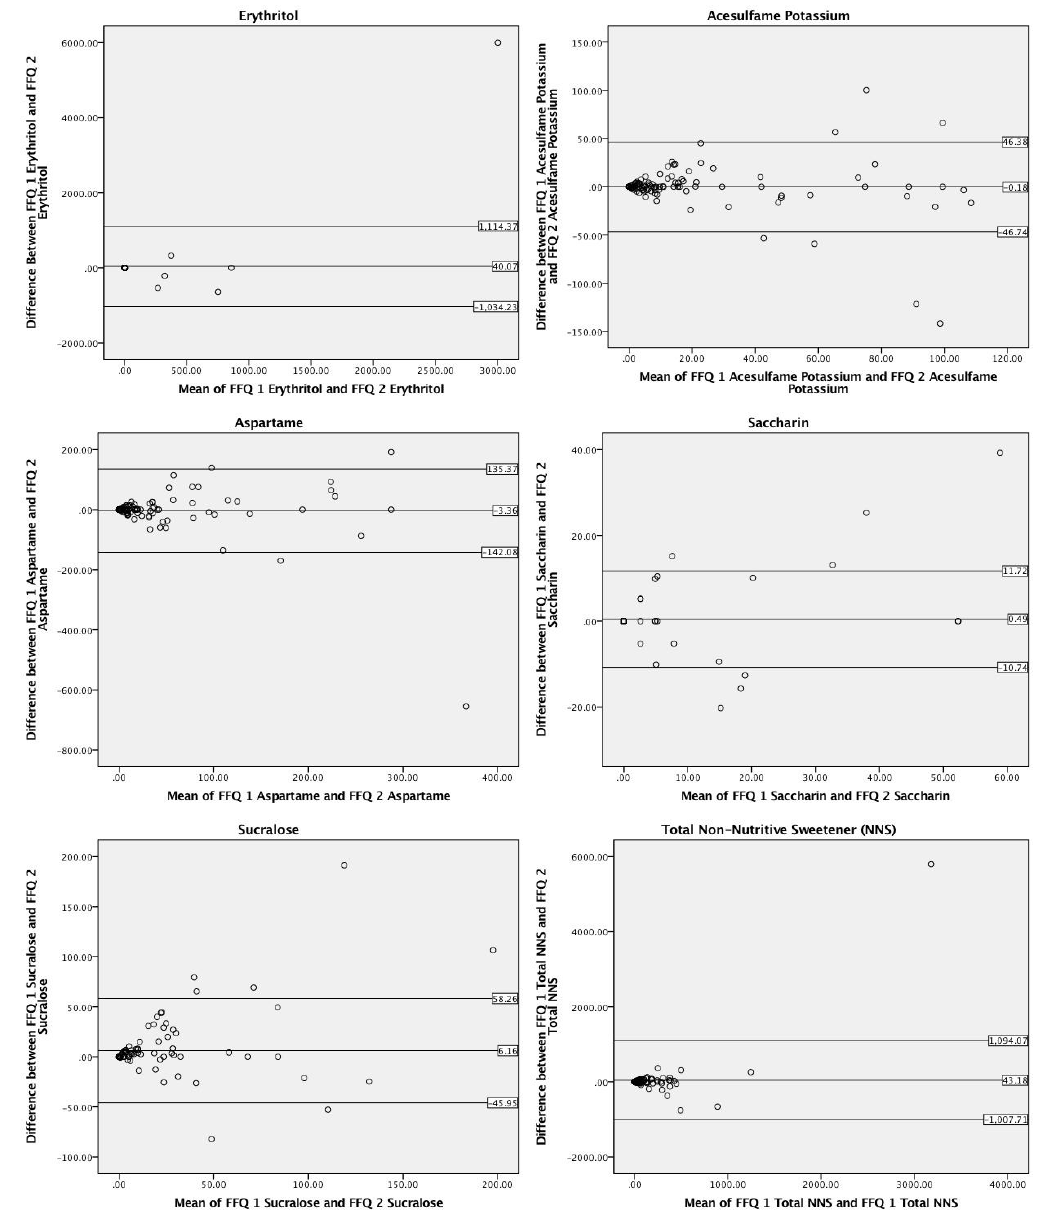
Figure 2. Bland–Altman plots of total and individual non-nutritive sweetener (NNS) mg consumption via two administrations of a NNS food-frequency questionnaire (NNS-FFQ 1 and NNS-FFQ 2). The center line represents the mean difference and the upper and lower lines indicate the mean ± 1.96 times the standard